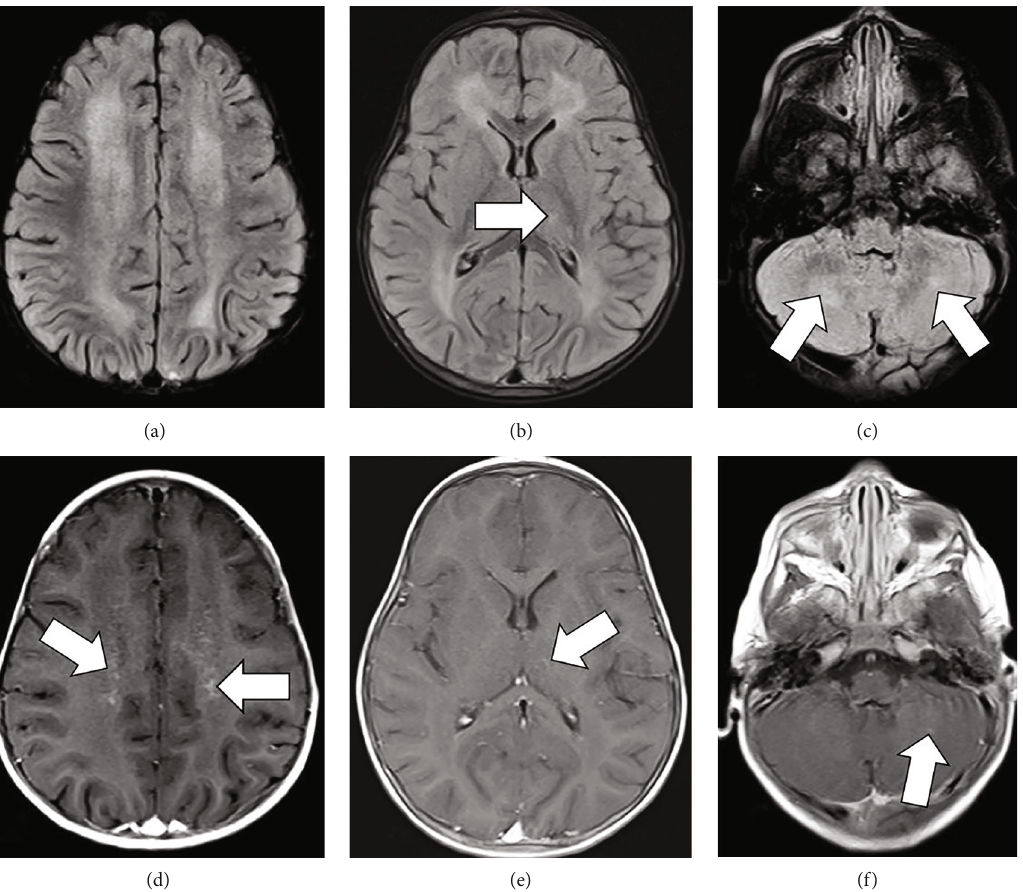
Figure 1: MRI obtained on admission demonstrating di ff use con fl uent symmetric T2 FLAIR hyperintensities in the supratentorial periventricular and deep white matter, sparing the subcortical U fi bers, and in bilateral cerebellar hemispheres around the deep nuclei (a – c). A focus of T2 FLAIR hyperintensity is noted in the lateral left thalamus (arrow in (b)). Postcontrast images reveals punctiform and curvilinear enhancement centered in bilateral supratentorial periventricular white matter with a perivascular distribution pattern (arrows in (d)). Foci of faint and curvilinear enhancement (arrow in (f)) were also present in bilateral cerebellar white matter. Small curvilinear enhancement was noted in the lateral left thalamus, likely re fl ective of a vein or a perivenous process (arrow in